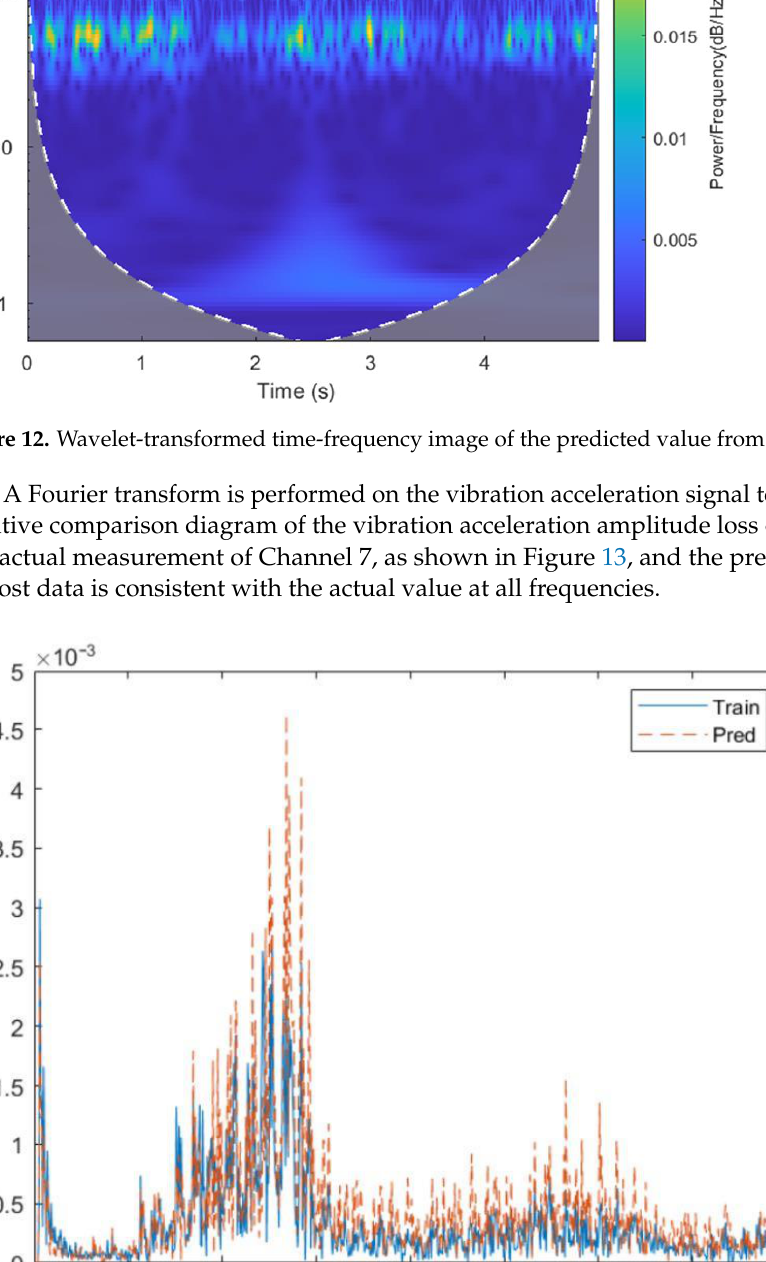
Figure 11. Wavelet-transformed time-frequency image of the measured value from Channel 7.